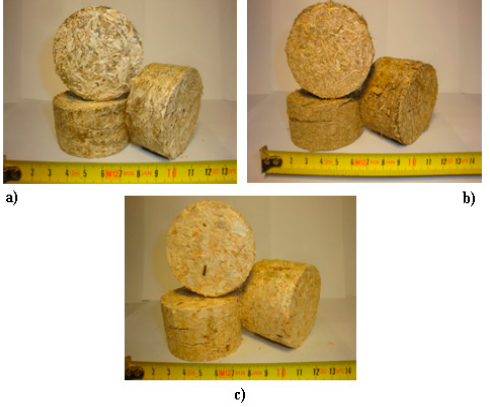
Figure 1. Produced briquettes made of different biomass sources: ( a ) hemp; ( b ) miscanthus; ( c ) pine sawdust.